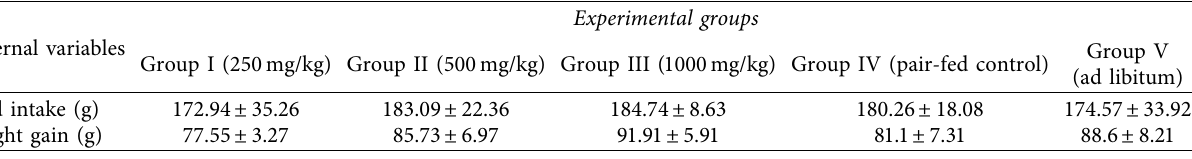
Table 5: Food intake and weight gain of pregnant rats treated with 80% ethanol fruit extract of Embelia schimperi